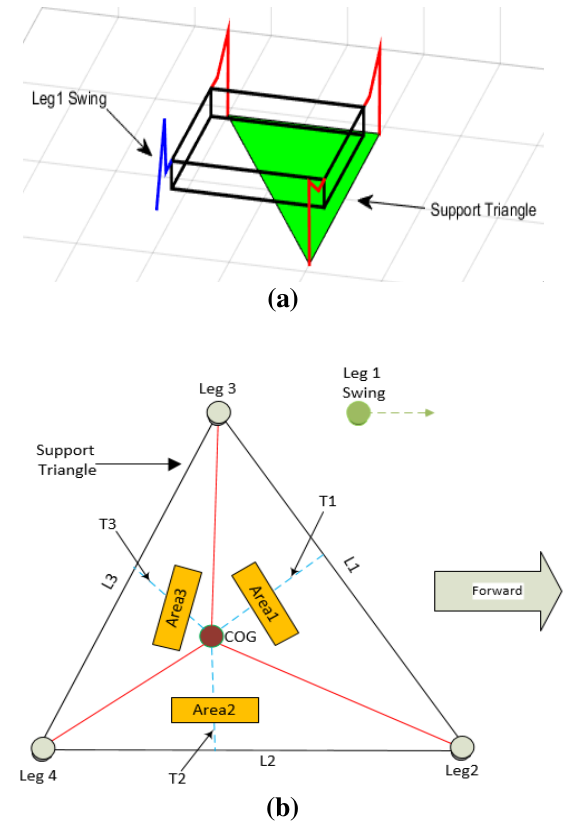
Fig. 11. Quadruped robot when leg3 is swinging (a) quadruped robot 3D view (b) Quadruped support triangle.